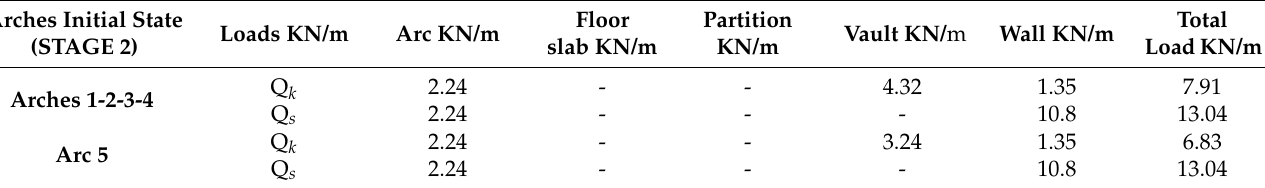
Figure 11. Force diagram of the intermediate state ( a ): arcs 1, 2, 3, and 4; ( b ): arc 5. Table 2. State of loads in the intermediate stage.